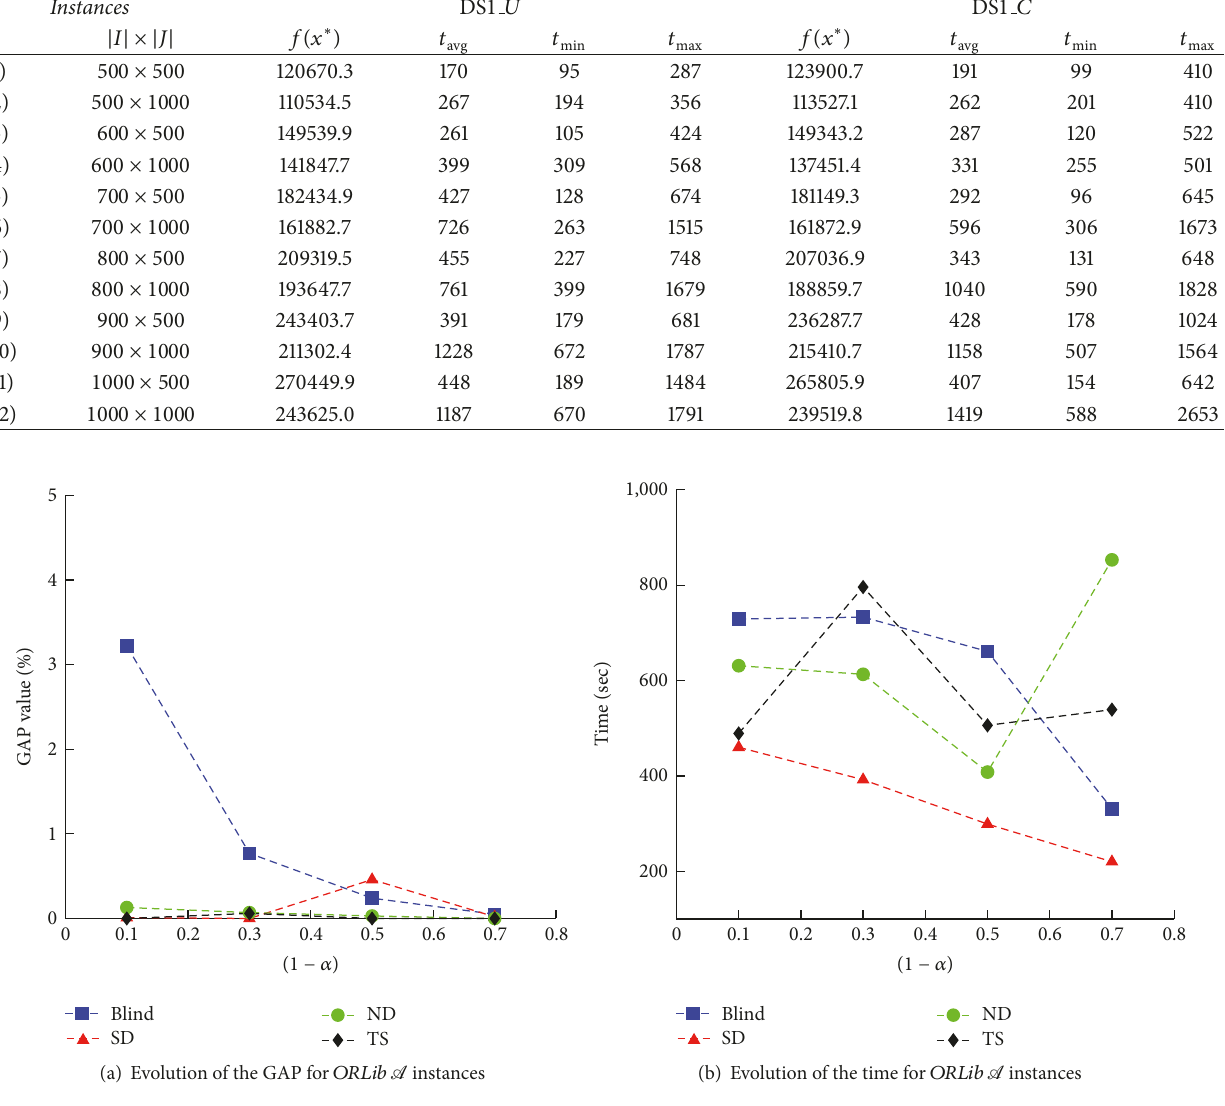
Figure 4: Average results obtained by the local search algorithms for each value of (1 − 𝛼) for 𝑂𝑅𝐿𝑖𝑏 A